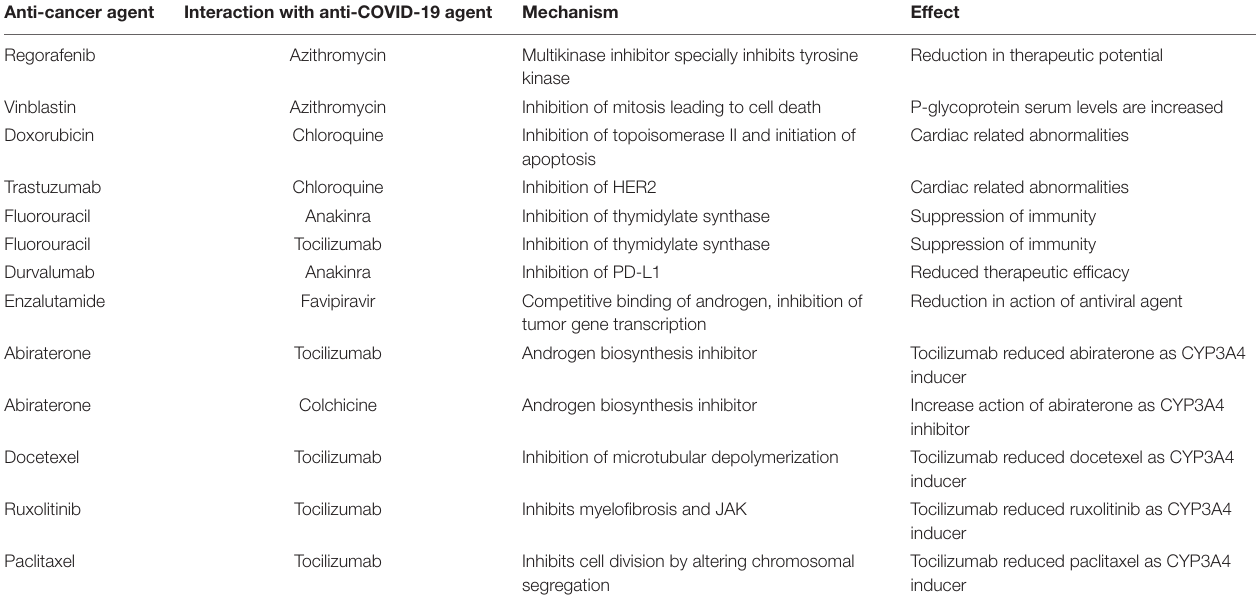
TABLE 1 | Anti-cancer agent interaction with COVID-19